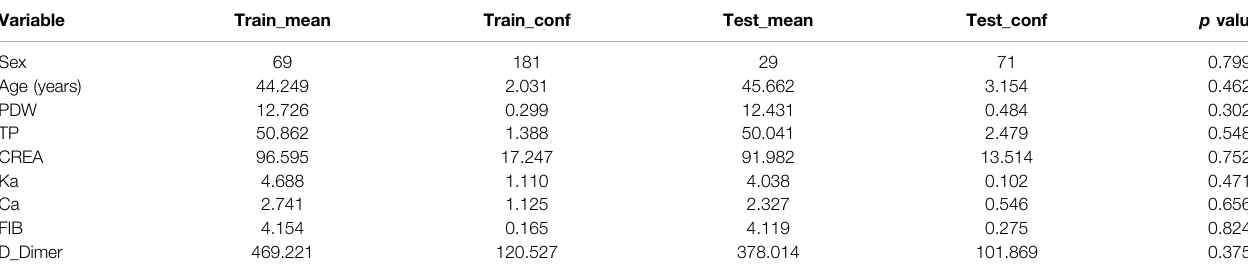
TABLE 4 | Basic information on the demographics and feature variables in the training and validation sets.